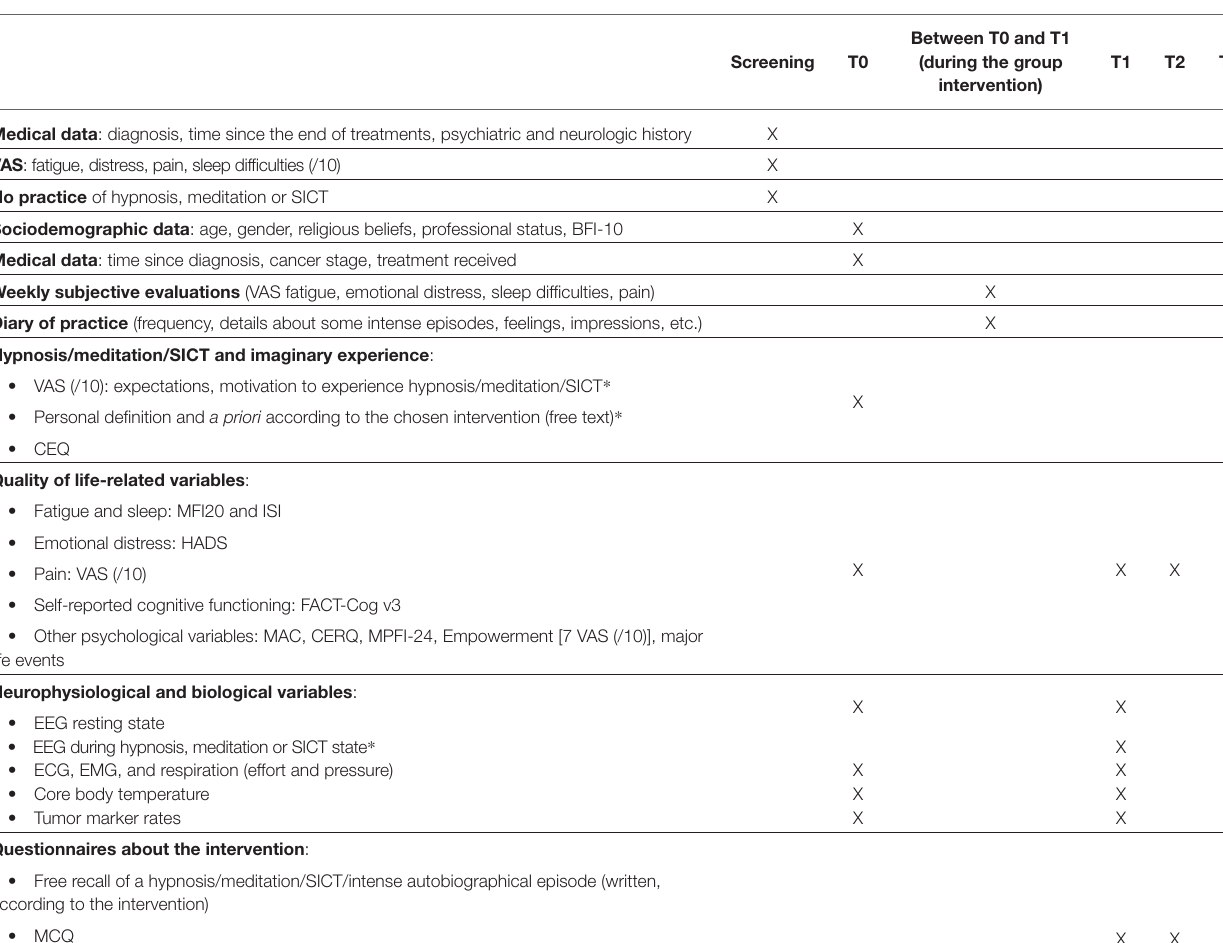
TABLE 1 | Measurements used in the study.